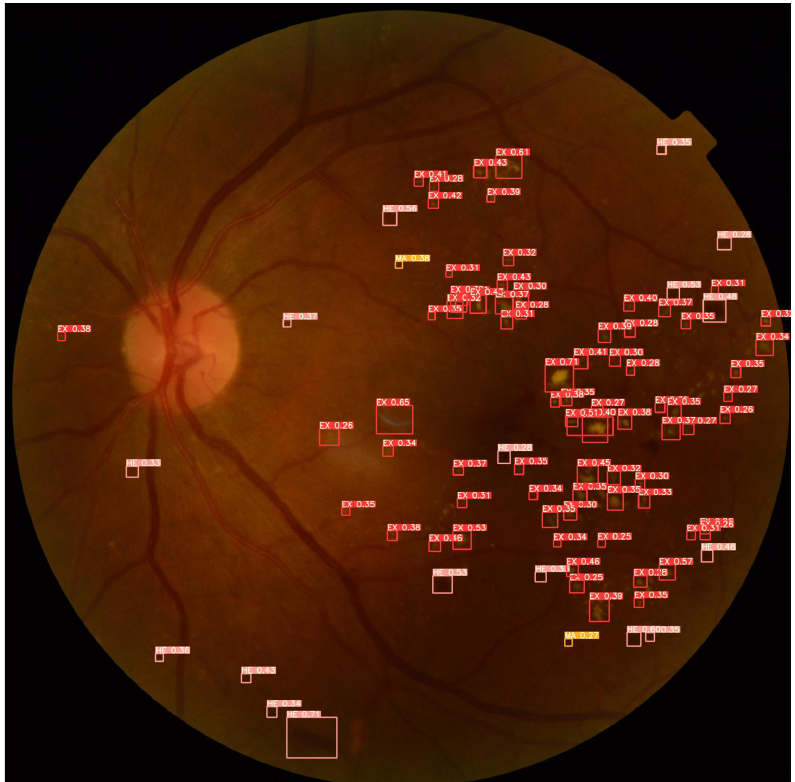
Figure 12. Detection of fundus lesions performed by the proposed approach and the percentage of confidence obtained in each object located in the fundus image “007-3711-200.jpg” of the test set of the Dataset for Diabetic Retinopathy (DDR). EX, hard exudates; HE, hemorrhages; MA,